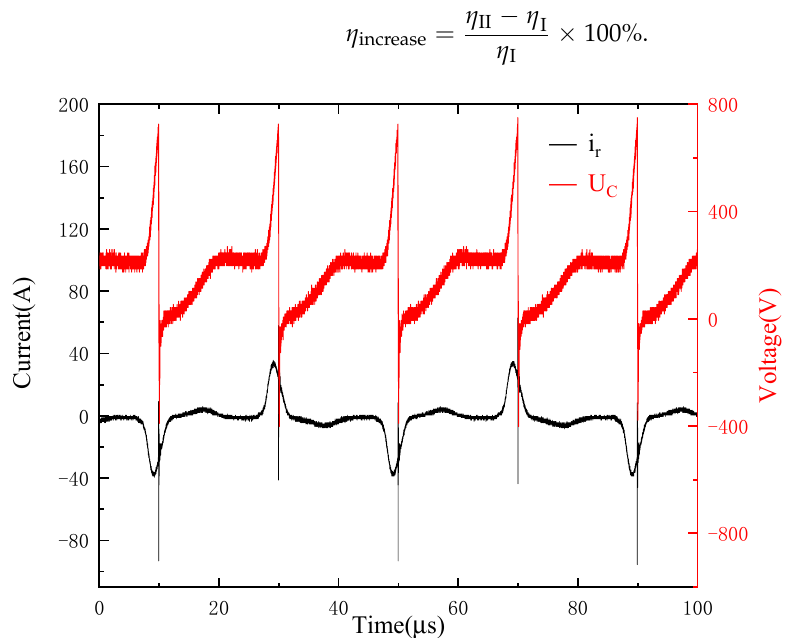
Figure 9. The waveform of the voltage on the energy-storage capacitors U c and the resonant current i r (circuit I).